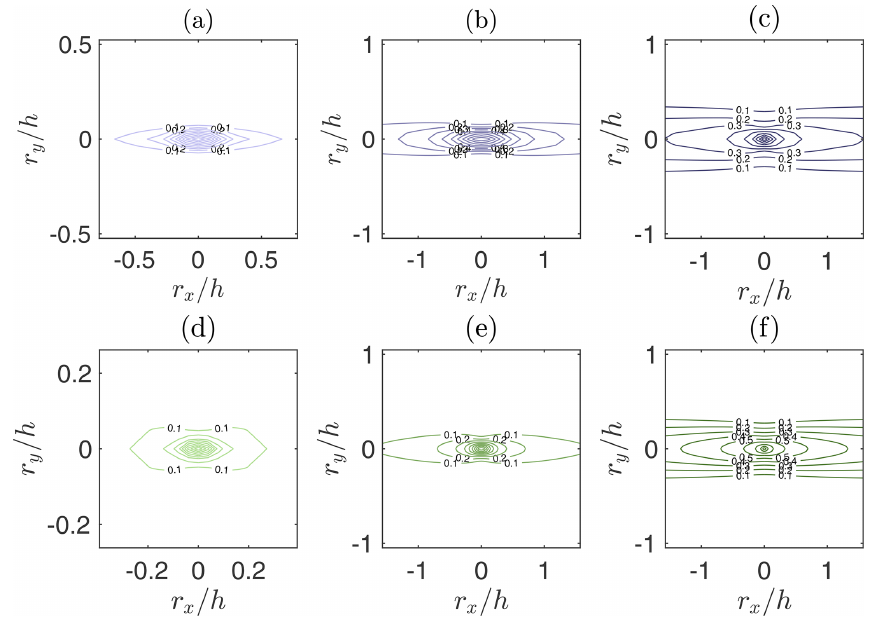
Figure 4. Contours of two-dimensional spatial autocorrelation of streamwise velocity at height z/h ≈ 0 . 1 from the simulations FV64 (a) ,